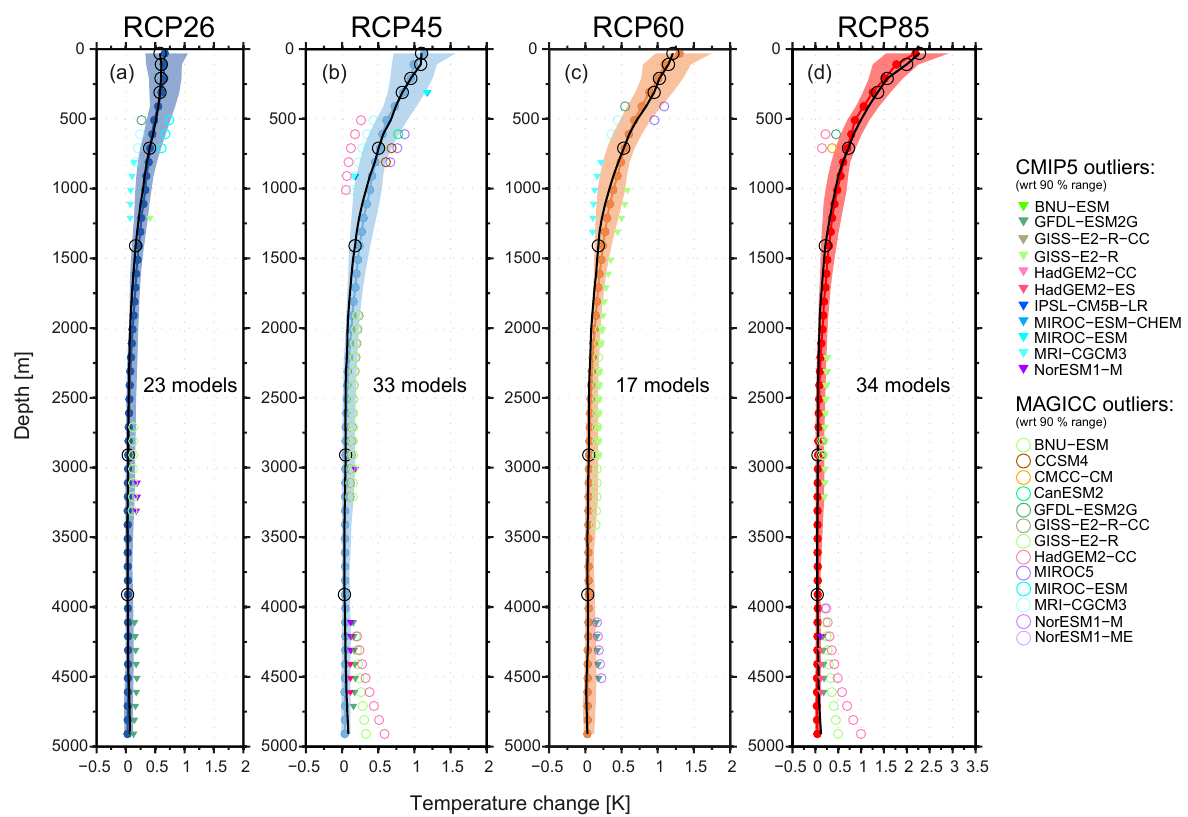
Figure 2. Potential ocean temperature depth profiles for MAGICC and reference CMIP5 warming under RCP2.6, RCP4.5, RCP6.0, and RCP8.5 scenarios, 2081–2100 anomalies with respect to 1986–2005. Interpolated CMIP5 90% model ranges and corresponding median profiles are shown in colors, with circles indicating the individual MAGICC ocean layers. MAGICC median ocean-warming profiles given as black lines with open circles indicating selected layers for ocean calibration. Model outliers not covered by the respective 90% ranges are shown for both CMIP5 reference data and MAGICC calibration results. Potential ocean temperature residuals of the calibration are provided for every MAGICC ocean layer in Fig.